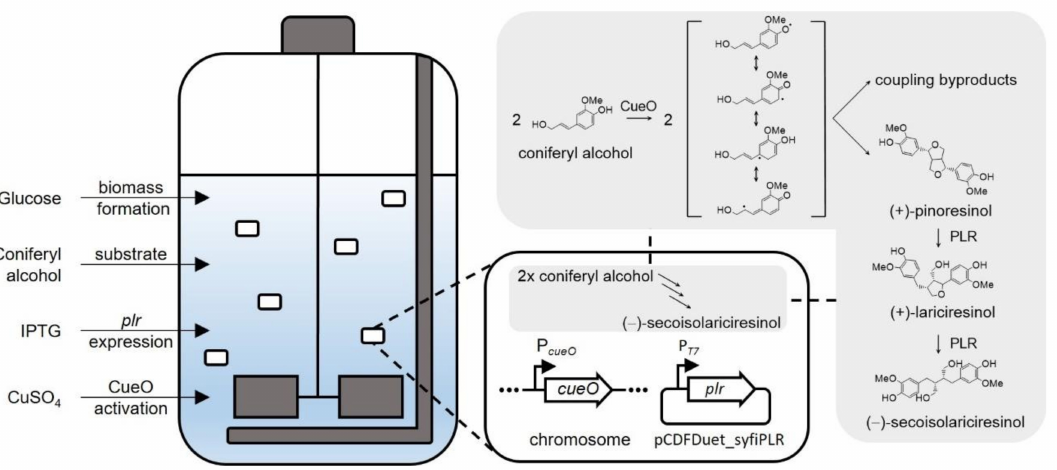
Figure 1. Design of a stirred-tank reactor (STR) bioprocess for SILR production. Host cell E. coli C43(DE3) harboring plasmid pCDFDuet_syfiPLR [11] was used for the synthesis of the endogenous laccase copper efflux oxidase (CueO) and recombinant pinoresinol–lariciresinol reductase